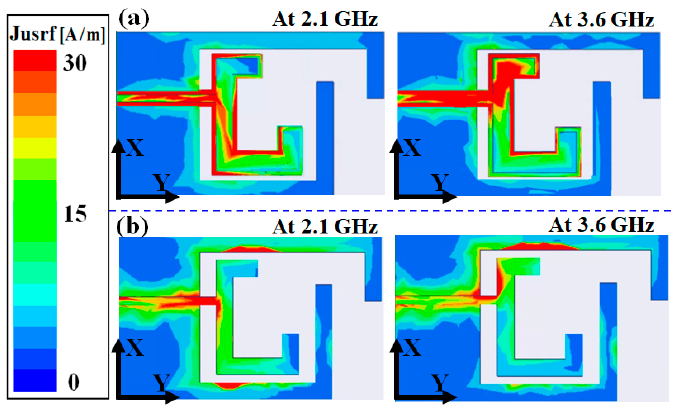
Figure 4. Surface current distributions of the dual-band transparent antennas ( a ) with the frame structure and ( b ) without the frame structure.